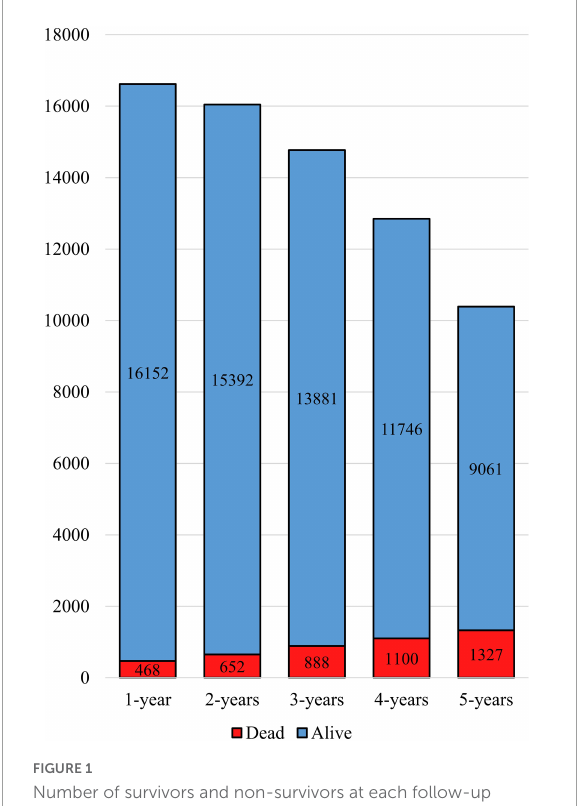
FIGURE1 Number of survivors and non-survivors at each follow-up